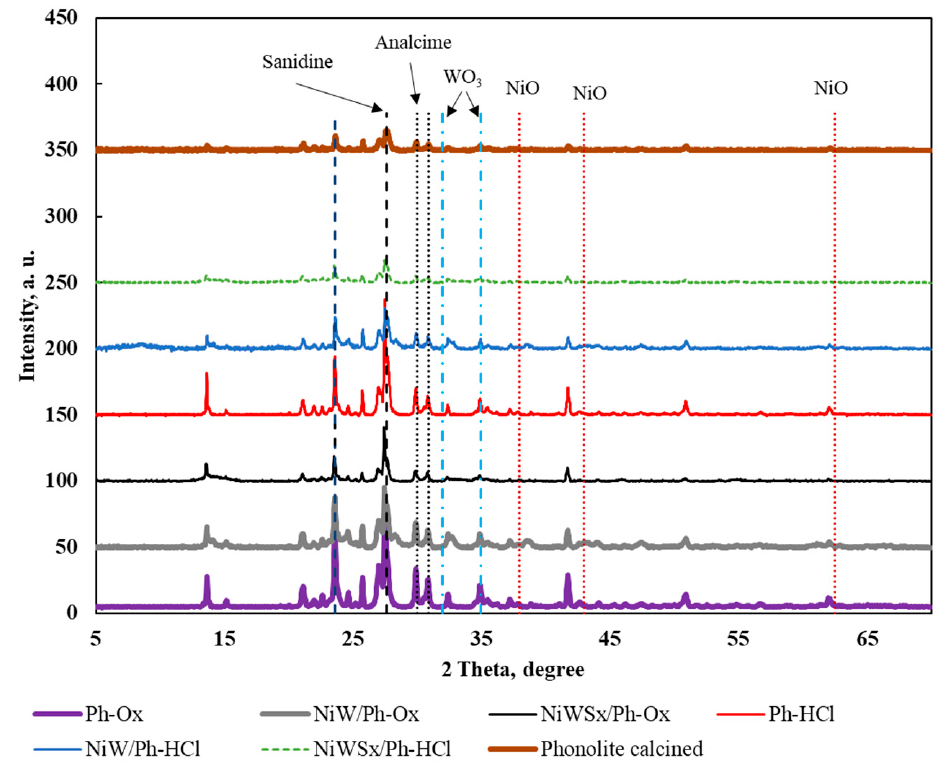
Figure 2. Wide angle X-ray di ff raction (XRD) patterns of the phonolite solids.